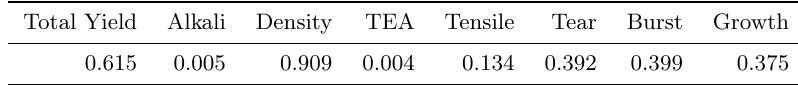
Table 2: Adequacies associated with the axes (variables) in Figure 2.